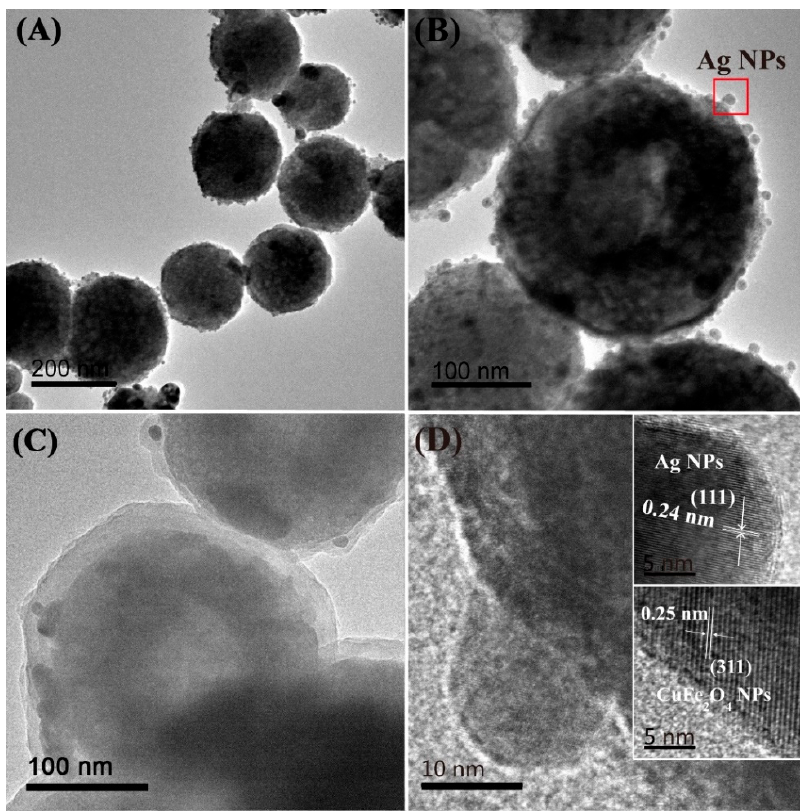
Figure 1. Transmission electron microscope (TEM) images of the CuFe 2 O 4 /Ag ( A ) and ( B ); CuFe 2 O 4 /Ag@COF ( C ); and HRTEM image of CuFe 2 O 4 and Ag ( D ).